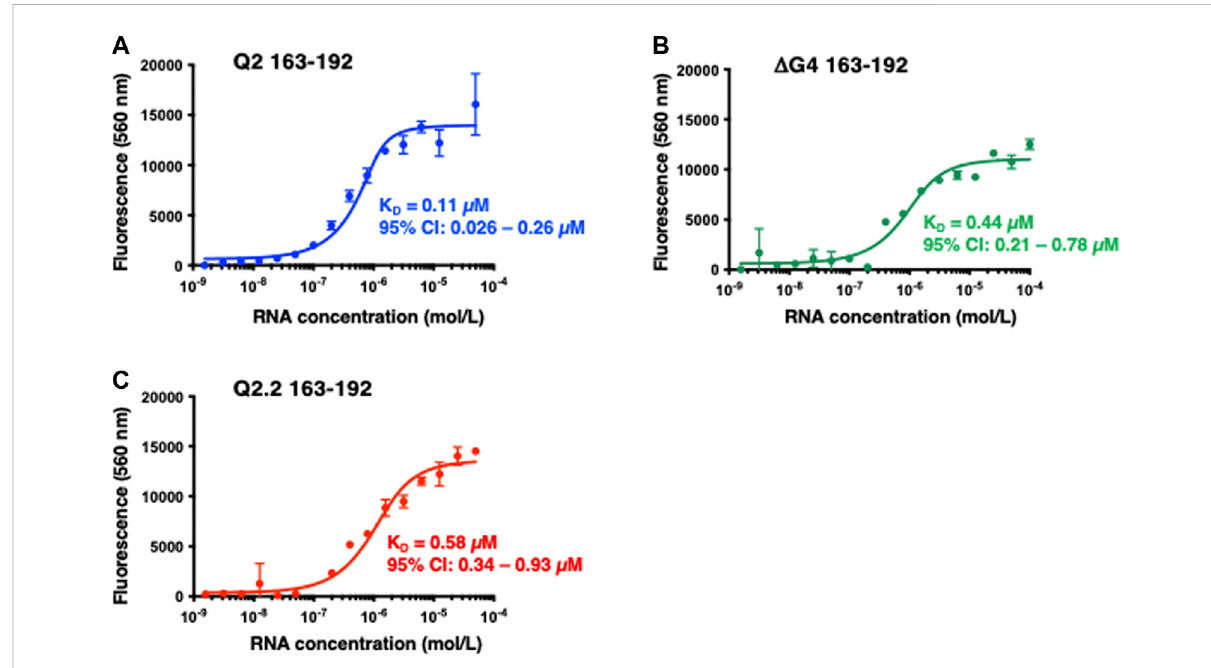
FIGURE 5 Fluorescence emission at 560 nm ( λ exc = 320 nm) of GQC-05 as a function of the indicated Bcl-x fragments concentration (A – C) Single-site fl uorescencebindingisothermsof1 µMGQC-05incubated withvaryingconcentrationsofQ2163 – 192 (A) , Δ G4163 – 192 (B) andQ2.2163 – 192 (C) . Experiments were conducted in 10 mM Tris pH 7.0, 100 mM KCl, at 20 °